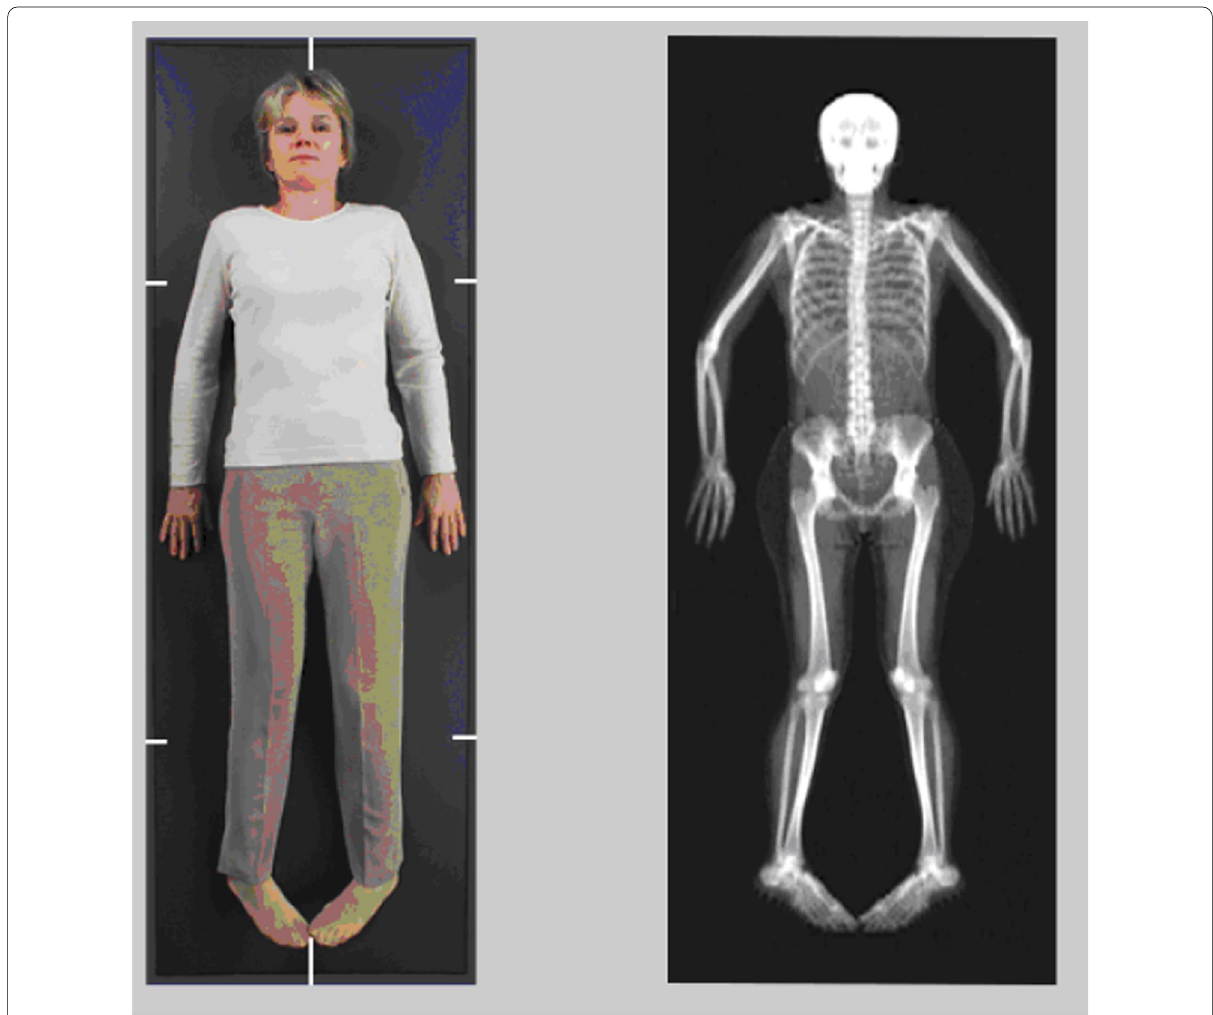
Fig. 7 Correct patient alignment according to the manufacturer of Hologic